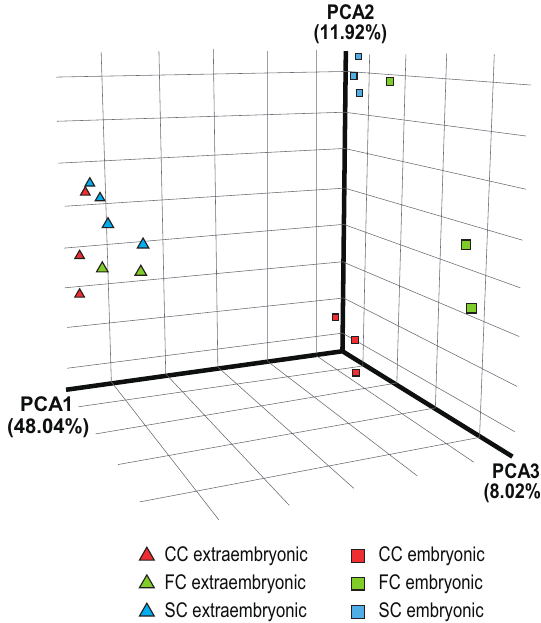
Figure 2. Principal component analysis (PCA) of global gene expression profiles. Visualization of gene expression similarities of samples clearly distinguishes donor cell-specific clusters of the embryonic samples (squares) from a donor cell-independent (i.e., SCNT-specific) overlapping cluster of extraembryonic samples (trian- gles). Red, green and blue represent cumulus cell-derived clone, fibroblast-derived clone and neonatal Sertoli cell-derived clone samples, respectively. Only the SCNT groups are presented based on the relative distance from the corresponding sex- and tissue type-matched IVF- derived control embryos. The result of conventional PCA, in which all IVF-derived samples were analyzed concomitantly, is shown in Figure